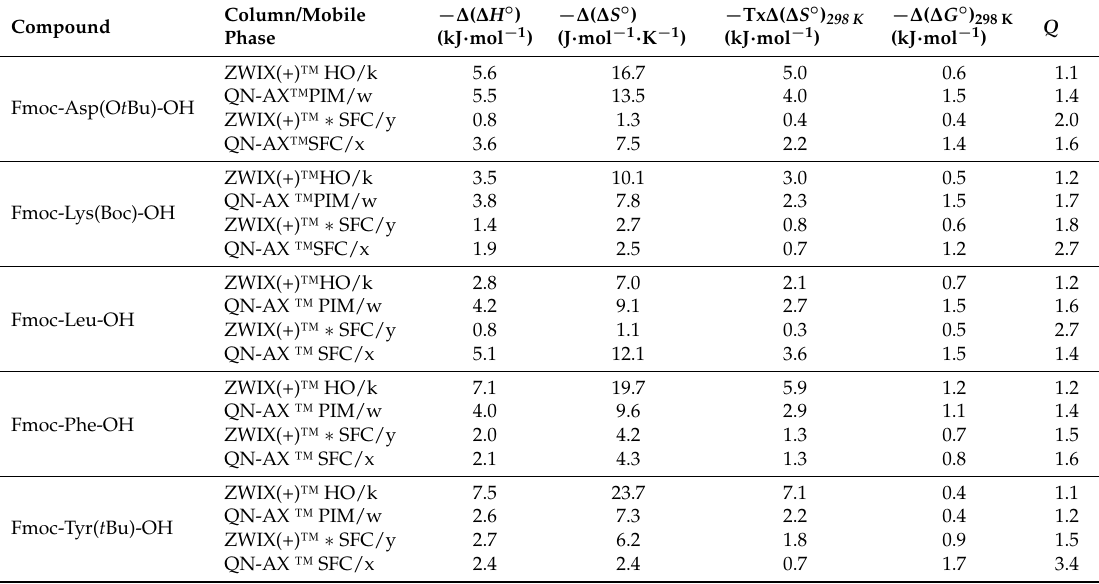
Table 3. Thermodynamic parameters, ∆ ( ∆ H ◦ ), ∆ ( ∆ S ◦ ), T x ∆ ( ∆ S ◦ ), ∆ ( ∆ G ◦ ), and Q values of N -Fmoc-protected protein amino acids on ZWIX(+) TM and QN-AX™ CSP in liquid chromatographic and SFC